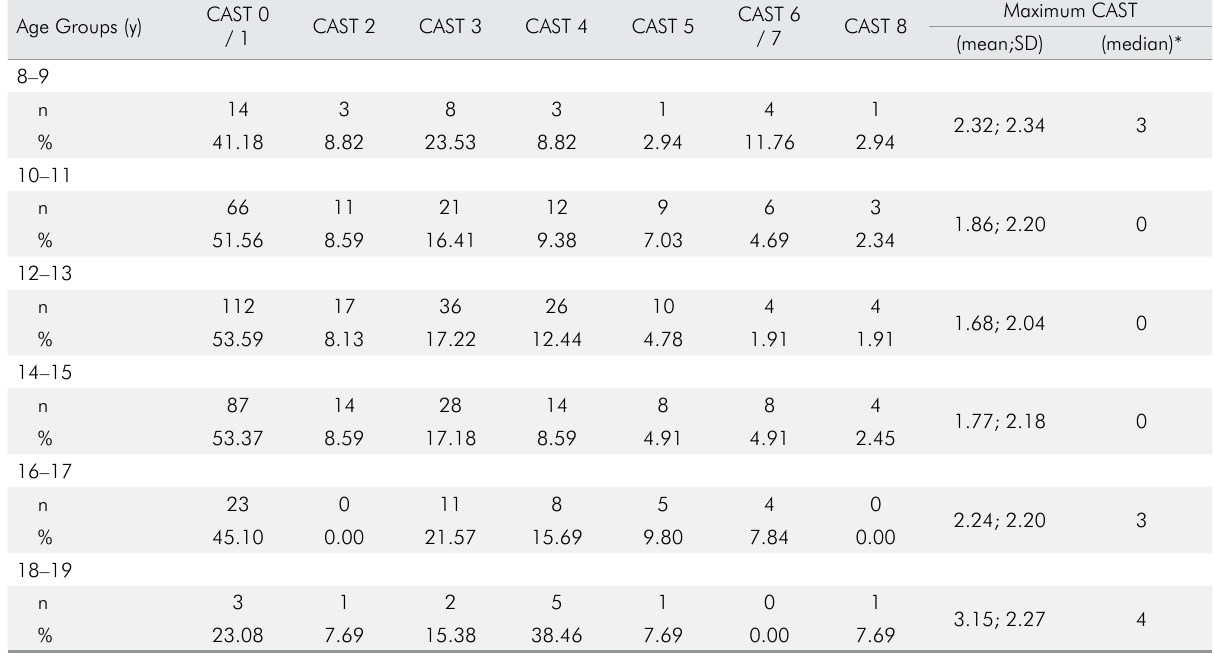
Table 4. Maximum cast and its components distribution, by age groups.